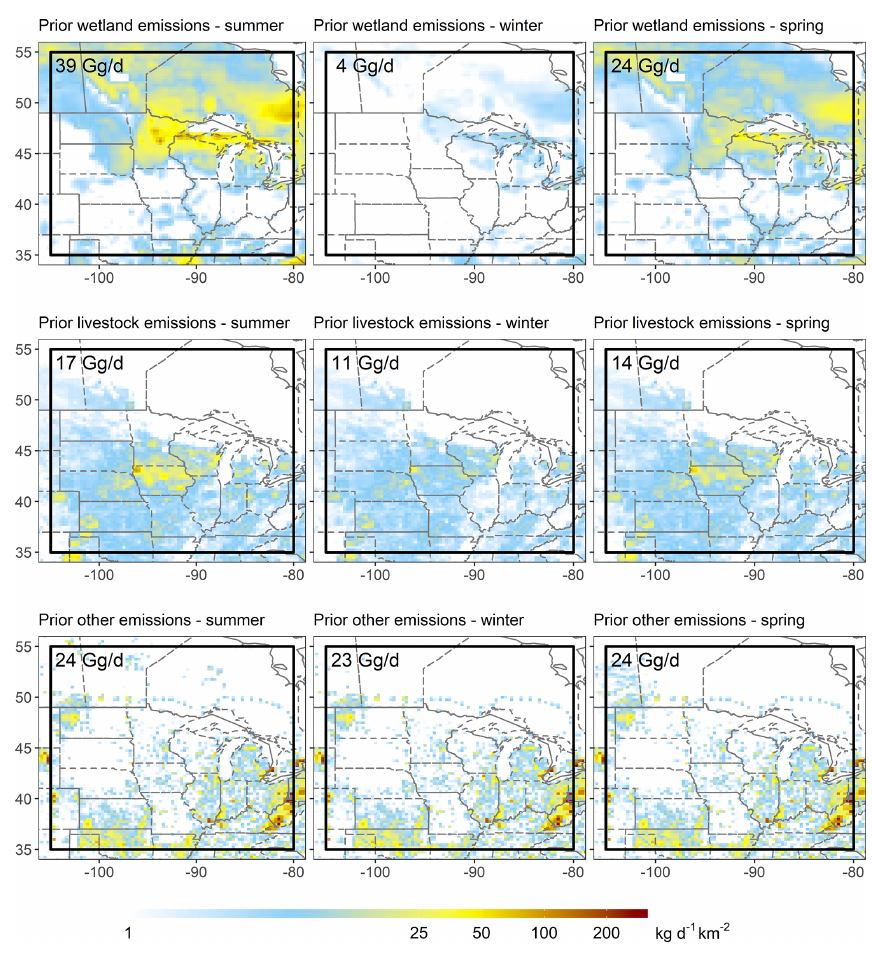
Figure 2. Prior methane emissions in the Upper Midwest for the GEM 1–3 flight periods (GEM1 – summer, 20 July–24 August 2017; GEM2 – winter, 3–28 January 2018; GEM3 – spring, 7 May–2 June 2018). Emission inventories are as described in the text. The black box indicates the inversion